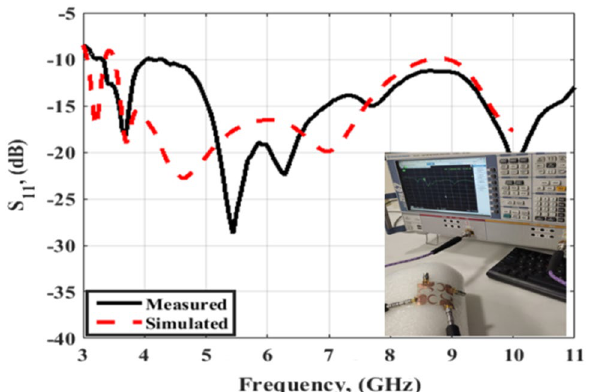
Figure 15. S 11 outcomes of the flexible MIMO antenna in bending configuration with R = 45 mm.